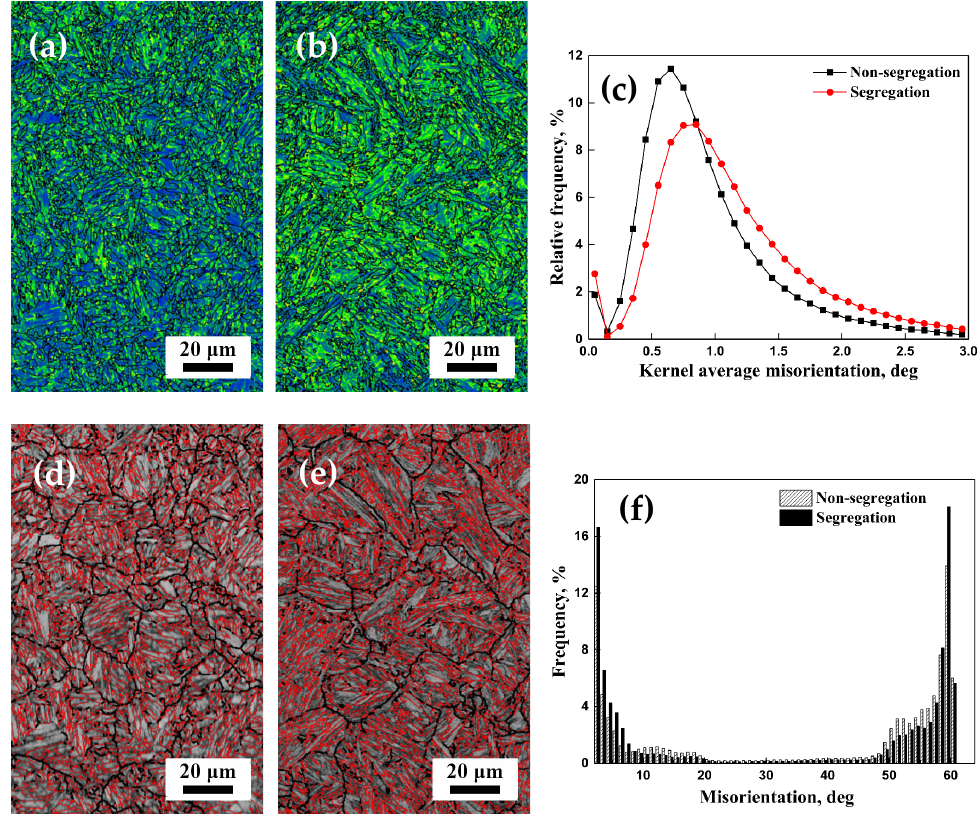
Figure 10. Kernel average misorientation (KAM) and image quality maps for the ( a ) non-segregation zone (NSZ) and ( b ) the segregation band. ( c ) Corresponding distribution of the KAM value. ( d ) NSZ, ( e ) segregation band and ( f ) misorientation distribution (black line 15° ≤ θ ≤ 50° and red line θ > 50°).